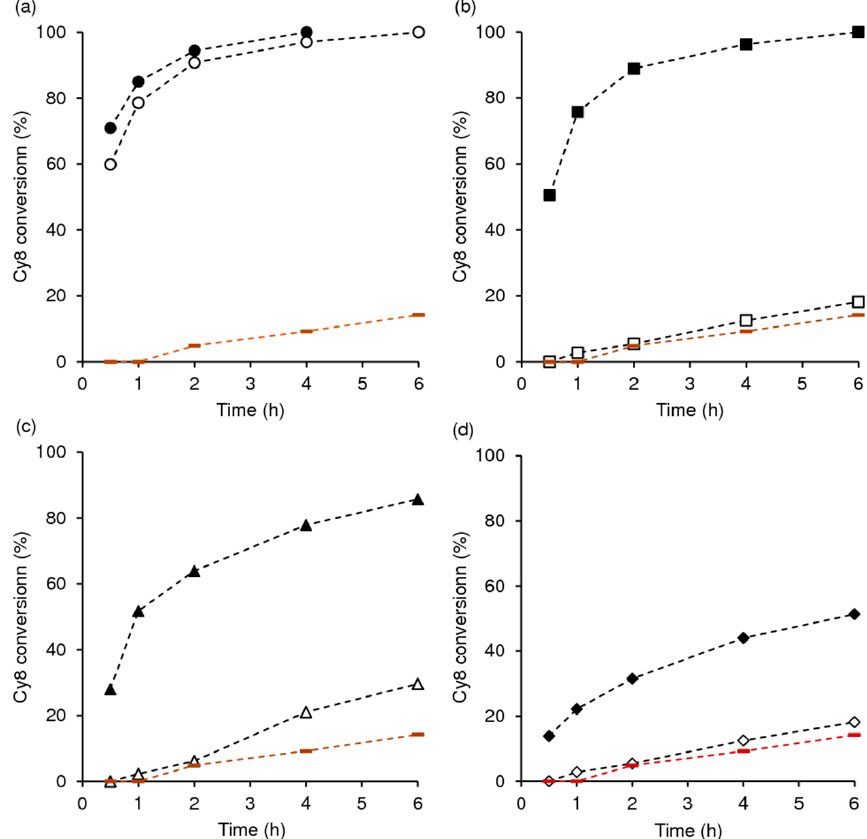
Figure 10. Comparison of the mesoporous silicates (solid symbols) to the respective molybdenum precursors (open symbols), for the epoxidation of cis -cyclooctene (Cy8) with TBHP at 70 °C: ( a ) Mo-TUD(IWI-acac) ( ● ) and precursor acac (o); ( b ) Mo-TUD(IWI-amm) ( ∎ ) and precursor amm ( (cid:0) ); ( c ) Mo-TUD(IWI-ahm) ( ▲ ) and precursor ahm ( Δ ); and ( d ) Mo-TUD(HT) ( ♦ ) and precursor amm ( ). For comparison, results for bulk MoO 3 (-) are included in ( a – d ). Epoxide selectivity was always 100%. For comparison, the free molybdenum precursor compounds (MoO 2 (acac) 2 (denoted acac), (NH 4 ) 2 MoO 4 (denoted amm) and (NH 4 ) 6 Mo 7 O 24 (denoted ahm) that were used to